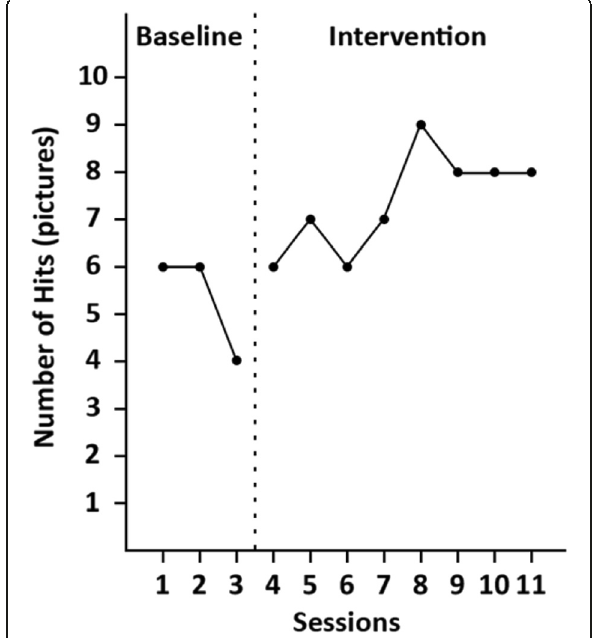
Fig. 2 Effectiveness of the digital memory game under the AB design. Legend: A – Baseline (without application of the digital memory game); B – Intervention (with application of the digital memory